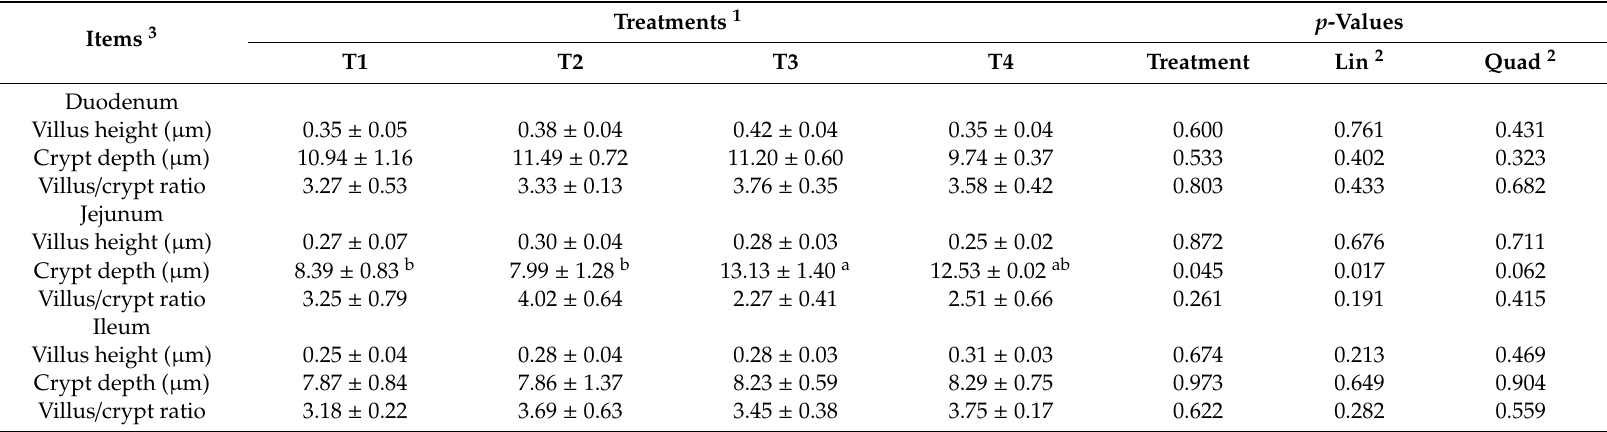
Table 9. E ff ects of the ratio of insoluble to soluble fiber in sow gestation diets on the morphometric measurements in the duodenum, jejunum, and ileum in weaned piglets.